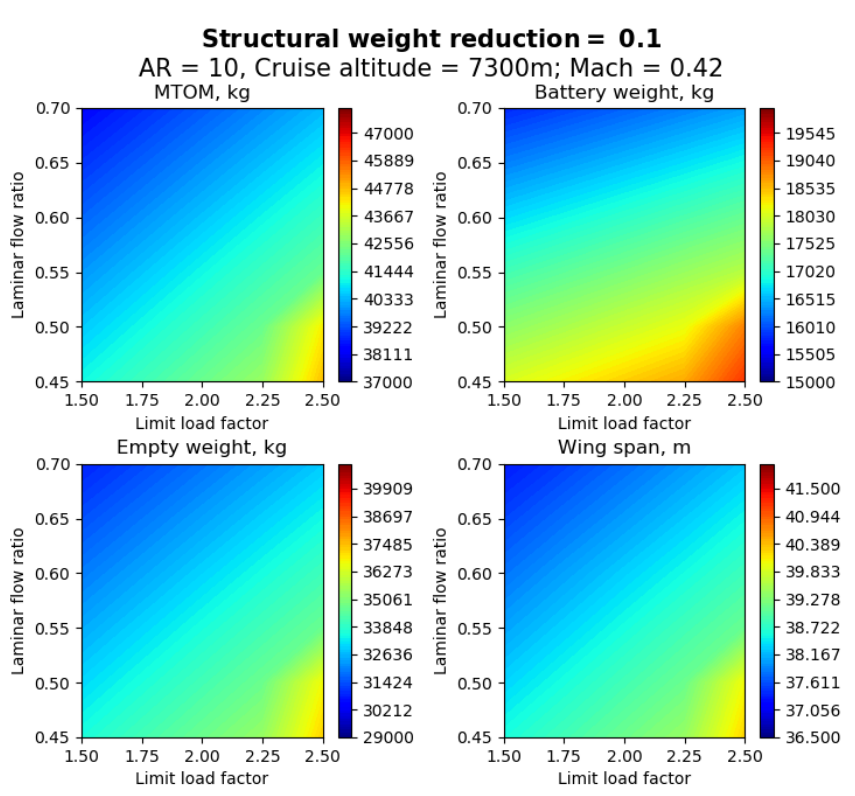
Figure 18. Sensitivity of aircraft characteristics to changes in technology levels at Structural weight reduction of 0.1.